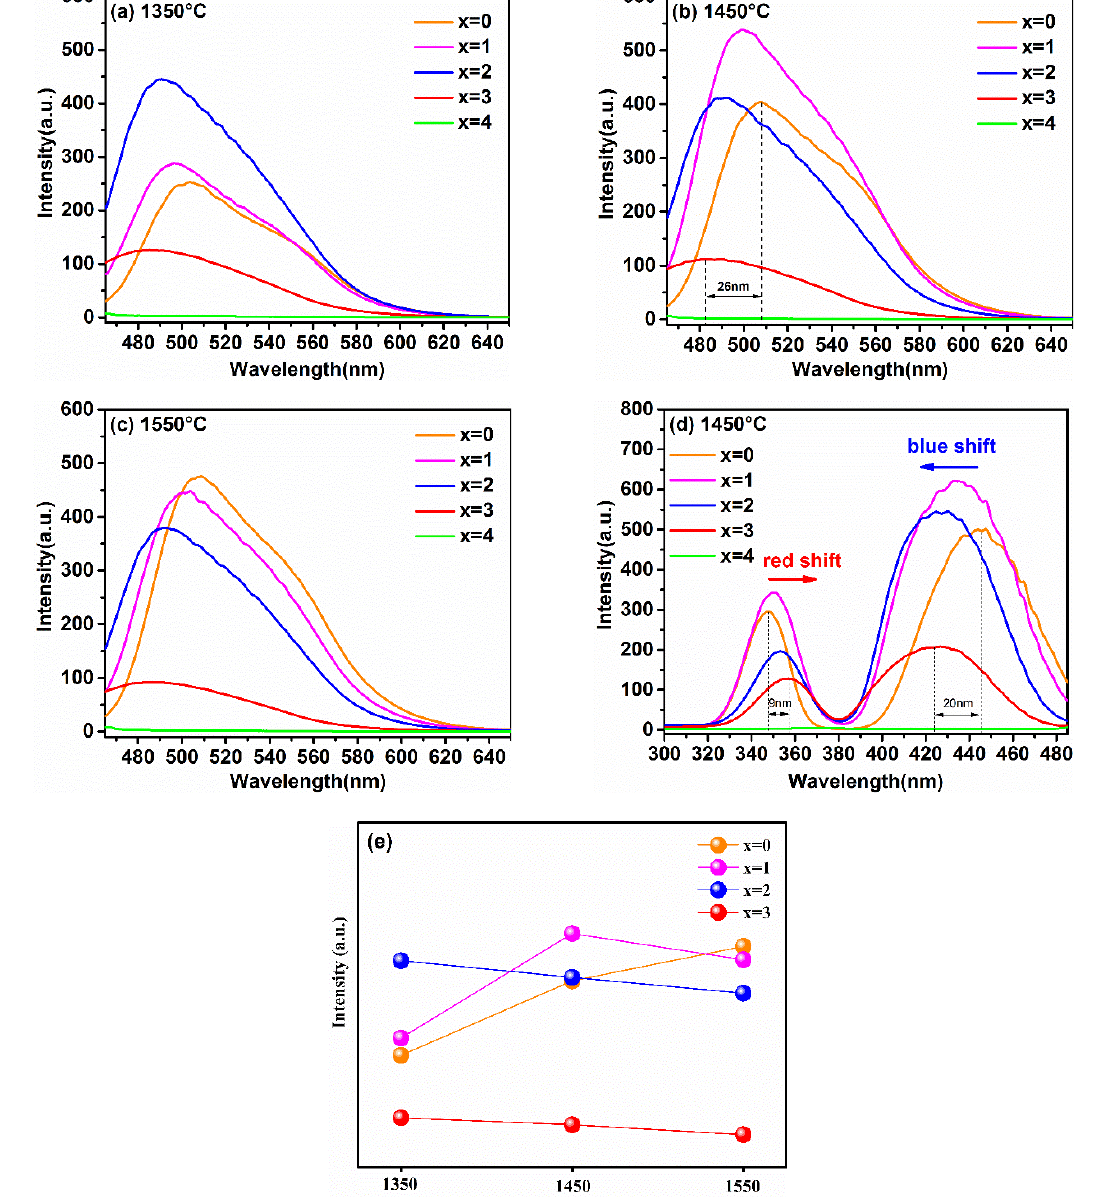
Figure 4. The emission spectra ( λ ex = 450 nm) of Lu 3 Ga x Al 5 − x O 12 : Ce 3+ (x = 0, 1, 2, 3, 4) at ( a ) 1350 °C, ( b ) 1450 °C, ( c ) 1550 °C, ( d ) the excitation spectra ( λ em = 500 nm) of samples synthesized at 1450 °C and ( e ) the relationship of the maximum emission intensity versus the sintering temperature at different Ga 3+ concentrations.